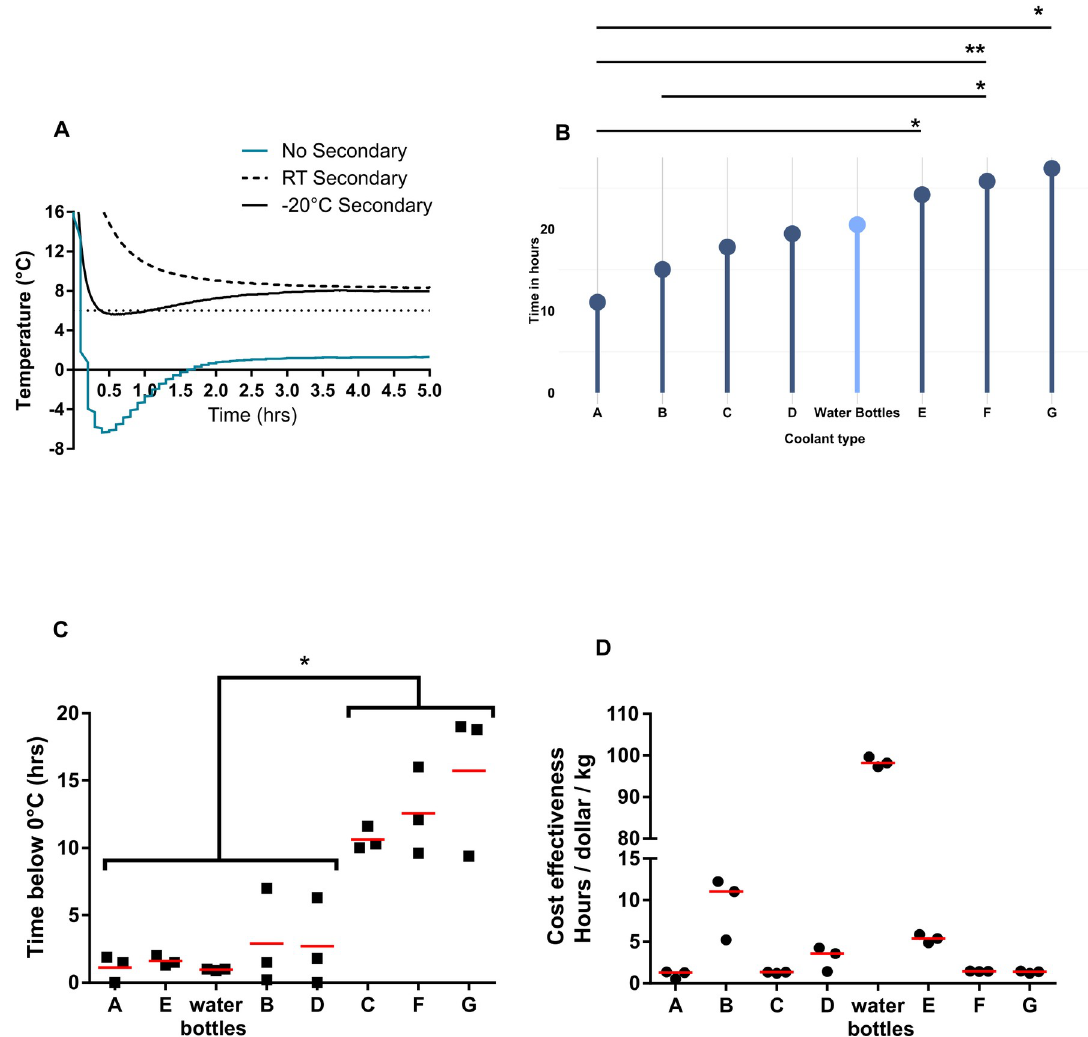
Fig 3. Comparison of cold packs and their cost efficiency. (A) Temperature curve in rotomolded cooler #13 with 0.45 kg of cold pack E with and without secondary containers. Lines represent the average of three experiments. (B) Cold time for various cold packs and the frozen water bottles in rotomolded cooler #13. Point represents the mean of three independent runs. Experiments were run in triplicate. Statistical significance was determined by a one way ANOVA with Tukey’s multiple comparison test. � P -value < 0.05, �� P -value < 0.01. (C) Time in hours 1 kg of cold packs remained below freezing when not in a secondary container. Each point represents an independent run and the red bar represents the average. Statistical significance was determined by a one way ANOVA with Tukey’s multiple comparison test. � P -value < 0.05. (D) Cost effectiveness of cold packs as determined by cold time in Fig 3A. Red bar represents the mean, n =